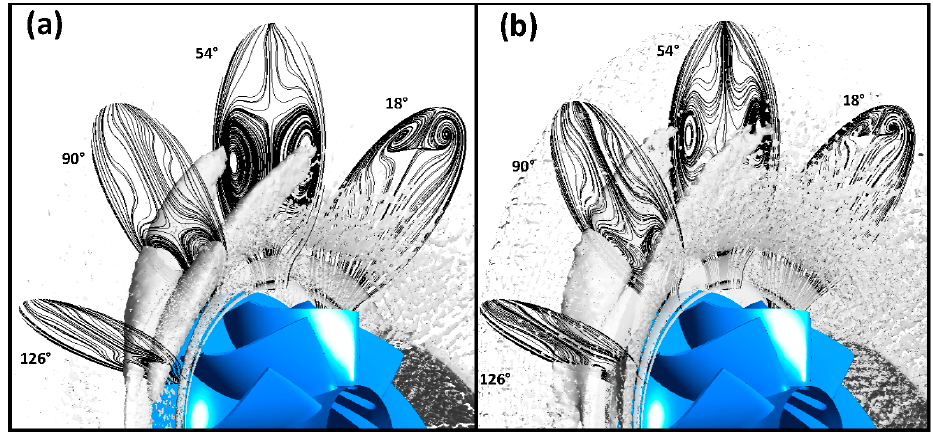
Figure 18. Lambda 2 parameter to show the vortex core development around AR = 0.5 volute. ( a ) Minimum incidence angle; ( b ) Maximum incidence angle.